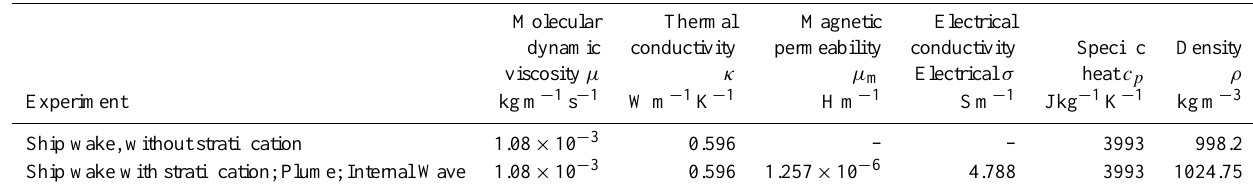
Table 1. Material properties.